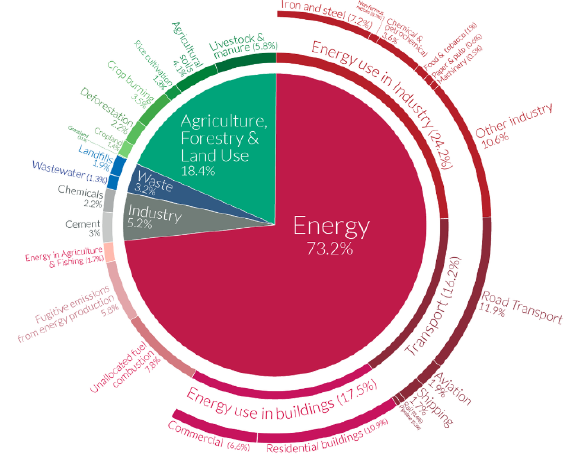
Figure 1. Global Greenhouse Gas Emissions by Sectors. Source: Ritchie and Roser (2020) (https://ourworldindata.org/emissions-by-sector) (accessed on 09 Aug 2021).